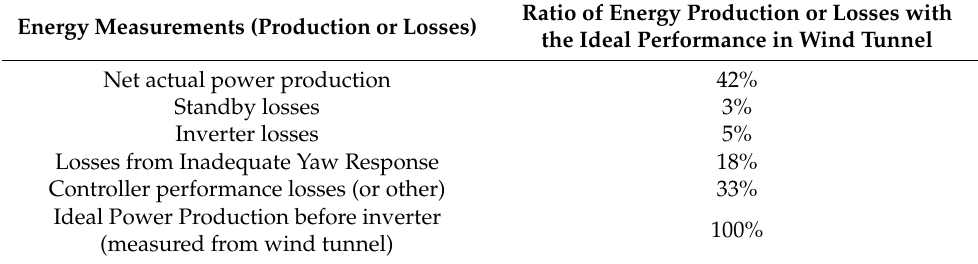
Table 6. Breakdown of ratio of energy measurements related to performance characteristics at field test with respect to the ideal performance in wind